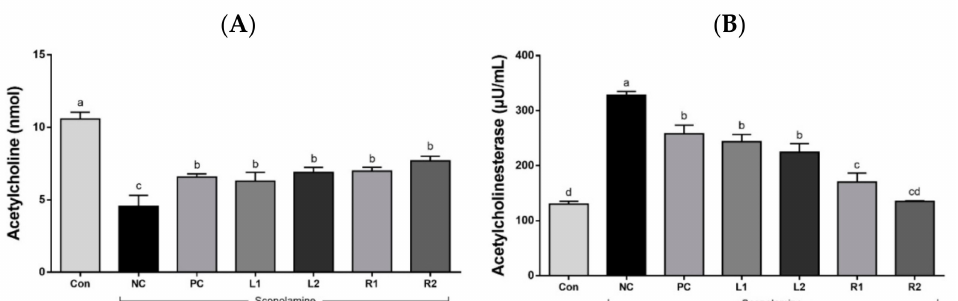
Figure 4. Effects of AH leaf and root extracts on cholinergic nervous system activity in the serum of C57BL/6 mice with scopolamine-induced memory impairment. ( A ) ACh concentration; ( B ) AChE activity. All values are expressed as the mean ± SEM ( n = 7). a–d Differences were considered statistically significant at p <